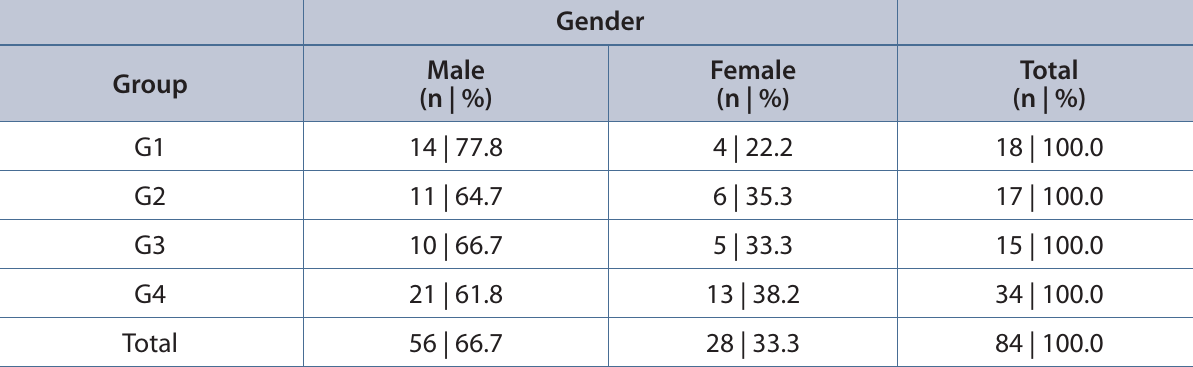
Table 1. Group and gender distributions of 50 HIV infected patients and 34 bone marrow transplant